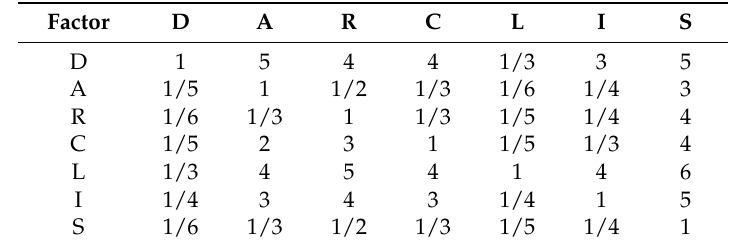
Table 5. Pairwise comparison matrix for calculating